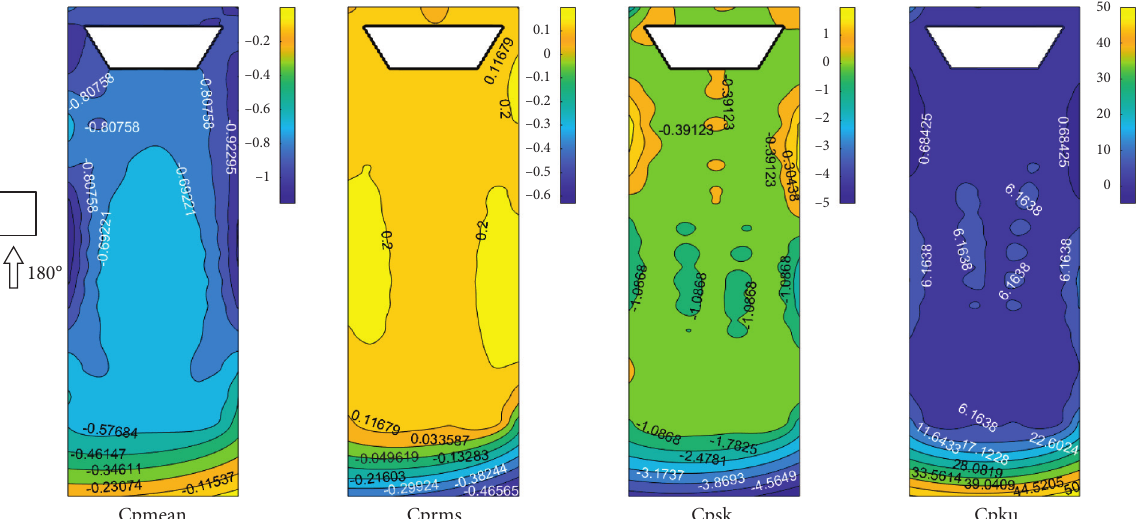
Figure 15: Distribution of statistics of building facade wind pressure coefficient at 180 ° wind